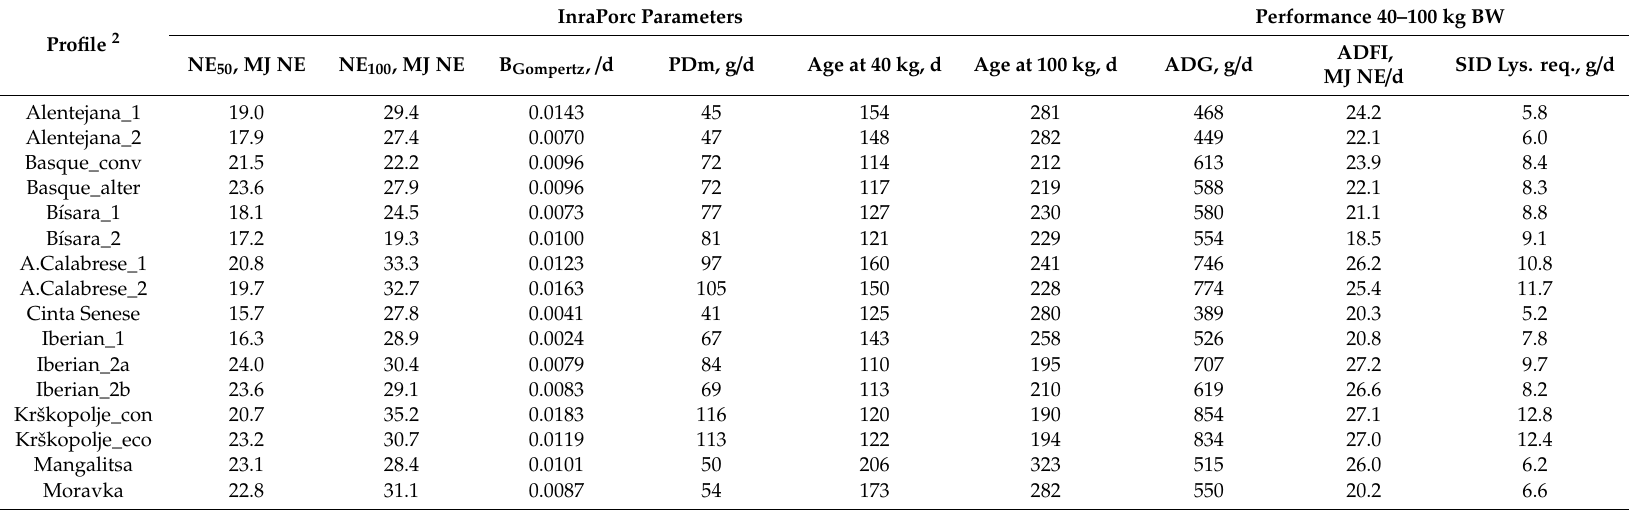
Table 2. InraPorc parameters of profiles and simulation results between 40 and 100 kg BW for nine local breeds 1